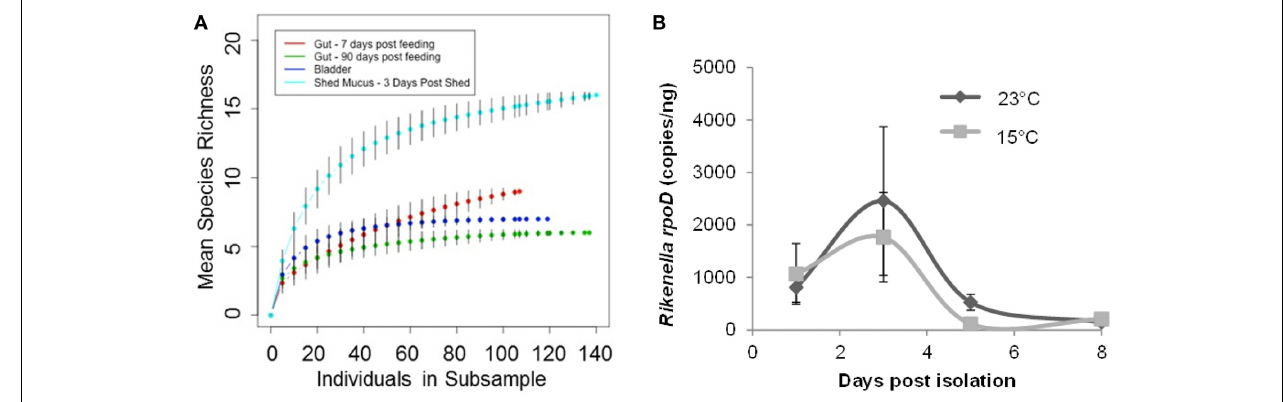
FIGURE 4 | Leech mucosal secretions contain a high diversity of microbial symbionts, to include the Rikenella -like bacterium. (A) Rarefaction curves were generated using Hurlbert’s formulation (Hurlbert, 1971) and are plotted with the mean species richness (y-axis) as a function of the number of individuals in each subsample (x-axis). The asymptotes rise less steeply as an increasing proportion of OTUs have been encountered.